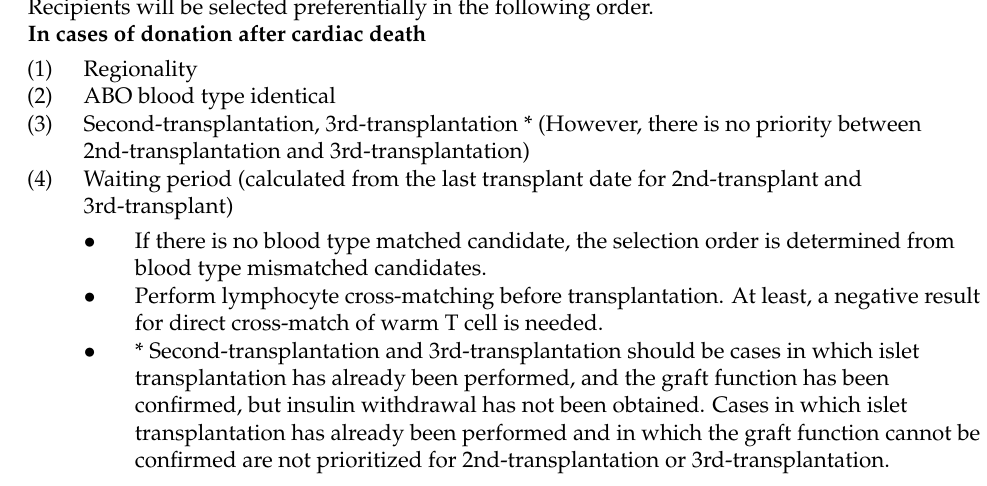
Table 3. Recipient selection criteria for islet transplantation. Recipients will be selected preferentially in the following